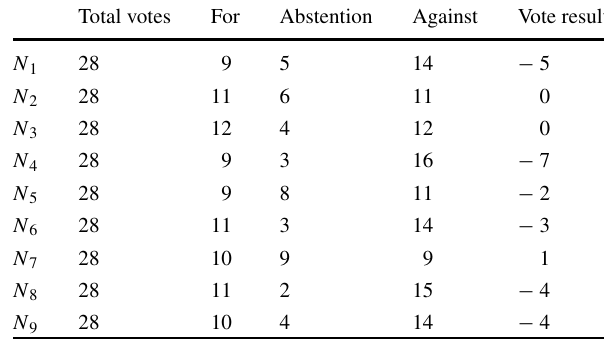
Table 11 Voting results for the nine nodes based on Li et al.’s method Total votes For Abstention